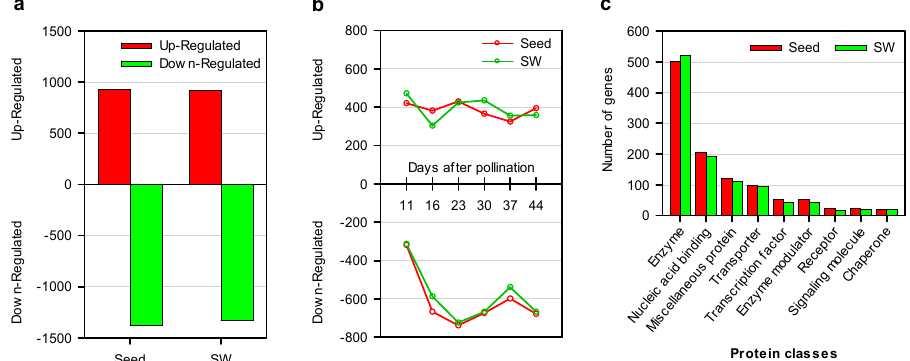
Figure 5. Up- and downregulated DEGs in seed and silique wall at different developmental stages. ( a ) Up- and downregulated DEGs of the HOCL as compared to LOCL. ( b ) Overall up- and downregulated DEGs in seed and SW of the HOCL. ( c ) Protein classification of DEGs using Protein Analysis Through Evolutionary Relationships (PANTHER). Total protein class hits were 1104 and 1074 in SW and seed, respectively.